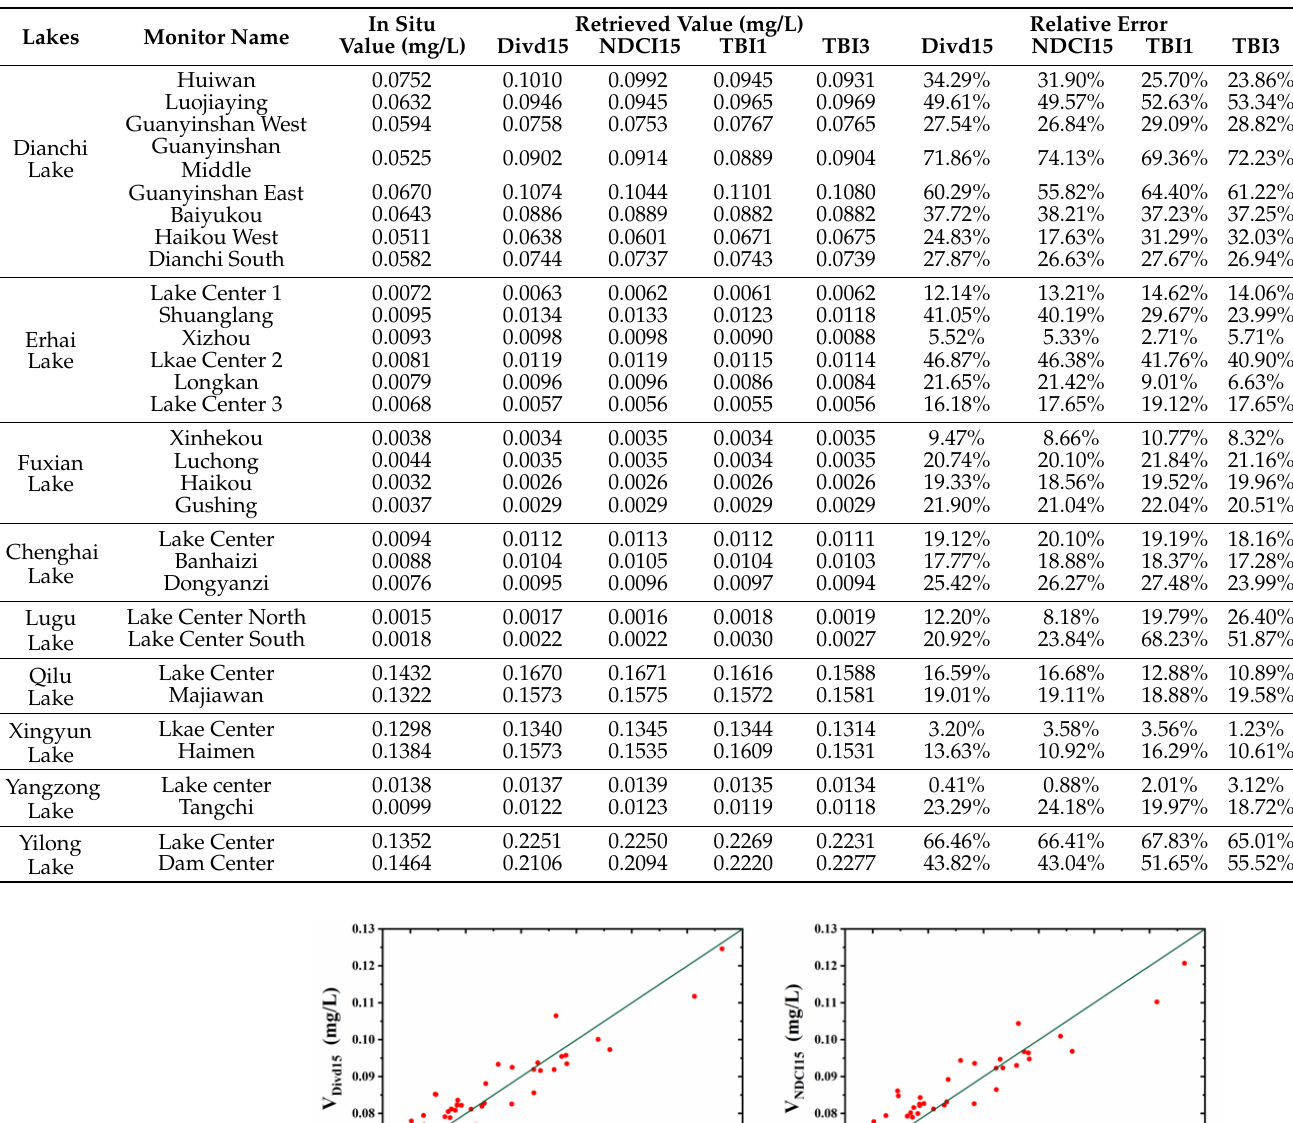
Table 6. Relative error of the CCAPL retrieval model.